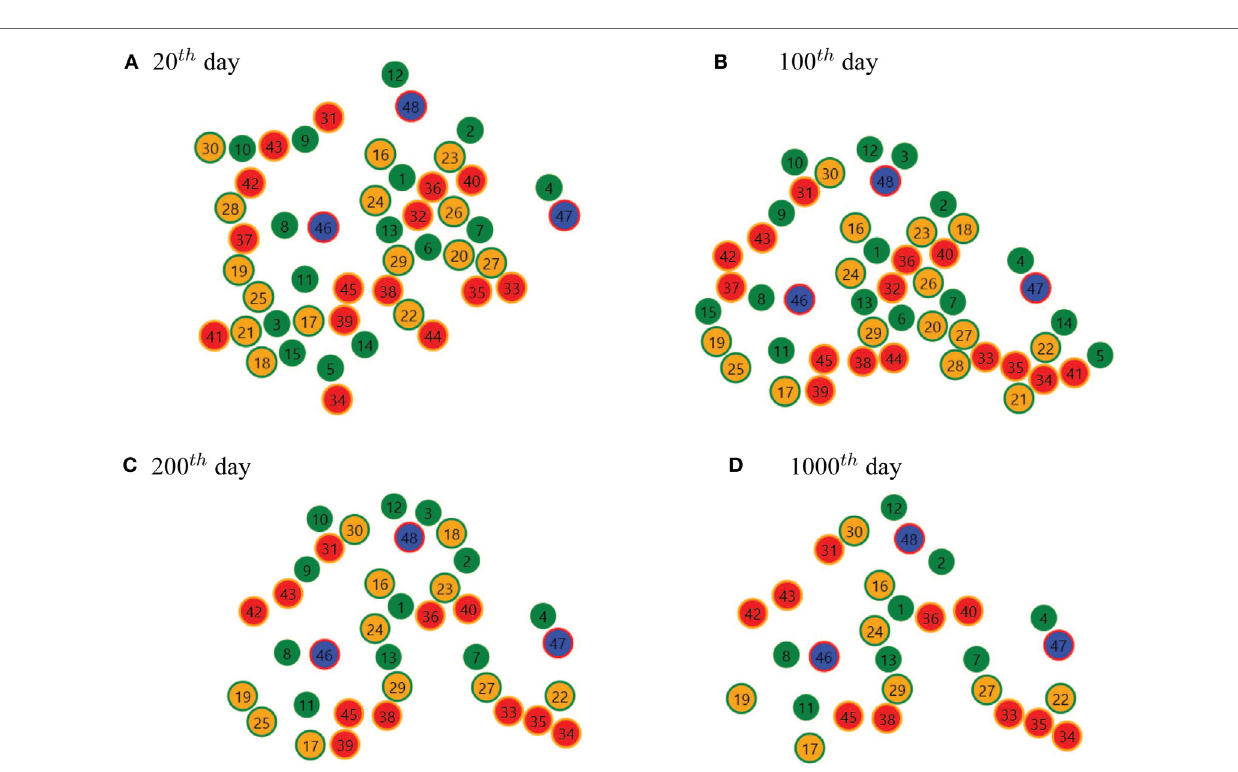
types in the 2D space are depicted. Labels near to data points represent consecutive (virtual) days, and color lines indicate the path traveled by an agent of a given type. In the case of a lower risk factor movements are steady, agents tend to some targets, and when they reach them, they rather stay there. In turn, as the risk factor is greater, agents seem to be in rather permanent movement, as if they were constantly looking for new opportunities.